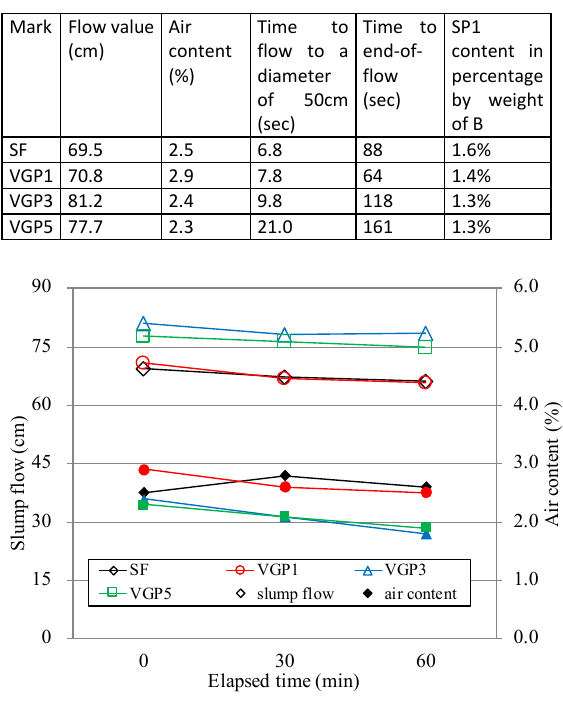
Figure 7. Slump flow and air content.